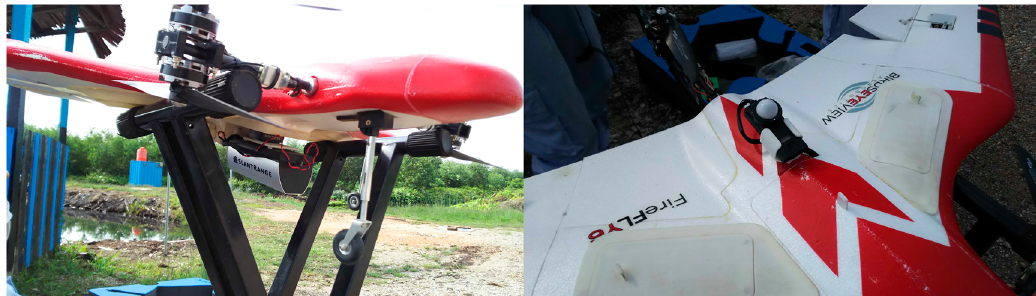
Figure 6. Firefly Pro 6 fixed-wing vertical takeoff and landing (VTOL) unmanned aerial system (UAS) carrying the multispectral sensor and the illumination sensor.